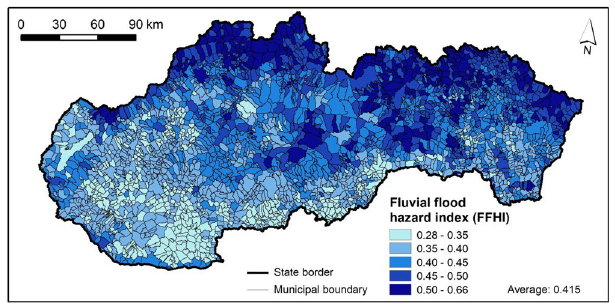
Figure 11. FFHI in municipalities of Slovakia. This figure was generated in ArcGIS 10.2.2 software.